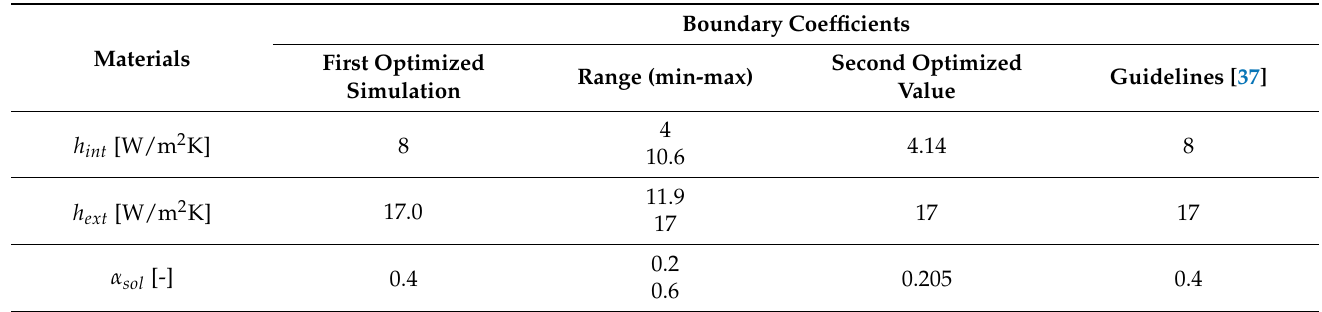
Table 5. Overview of the first optimized simulation, range of variation, best solution, guidelines, or standard value for the boundary coefficients.